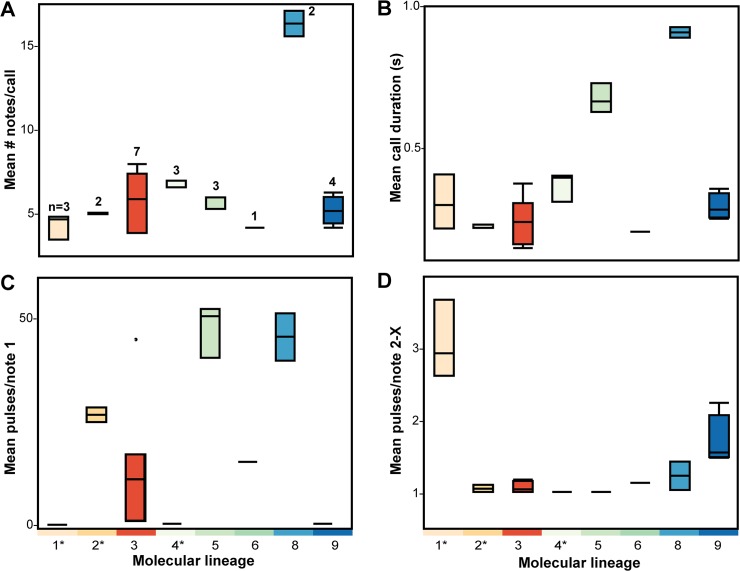
Boxplots of (A) mean number of notes per advertisement call, (B) mean call duration, (C) mean pulses in note 1 and (D) mean pulses in notes 2–X in frogs in each of the nine molecular lineages identified in Leptolalax applebyi group.Currently recognized species are marked with an asterix (1 = L. applebyi, 2 = L. melicus, 4 = L. bidoupensis). Vertical lines within each box represent the median and boxes encompass the 75th and 25th quartiles. Sample size varied each molecular lineage and is displayed on panel A. Measured variables did not vary significantly with SVL (mm) or temperature (°C).